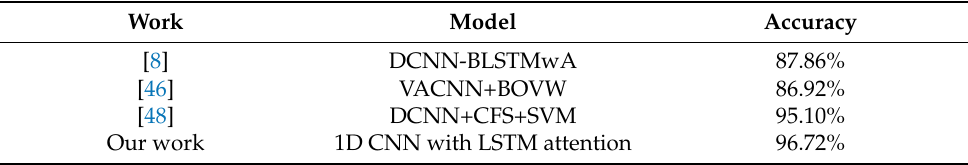
Table 6. Performance comparison of the works in the EMO-DB dataset.